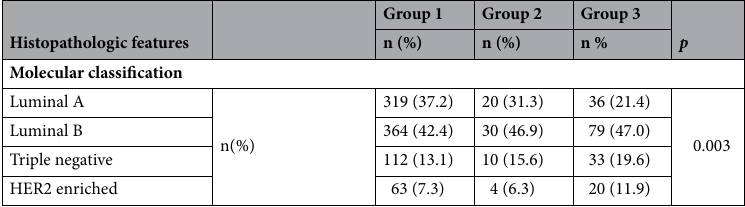
Table 4. The histopathologic features of the tumors. IDC invasive ductal carcinoma, ILC invasive lobular carcinoma, ER estrogen receptor, PR progestrone receptor.